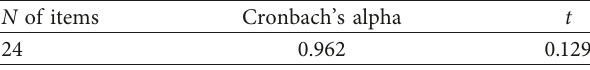
Table 3: Analysis results of learning engagement questionnaire. N of items